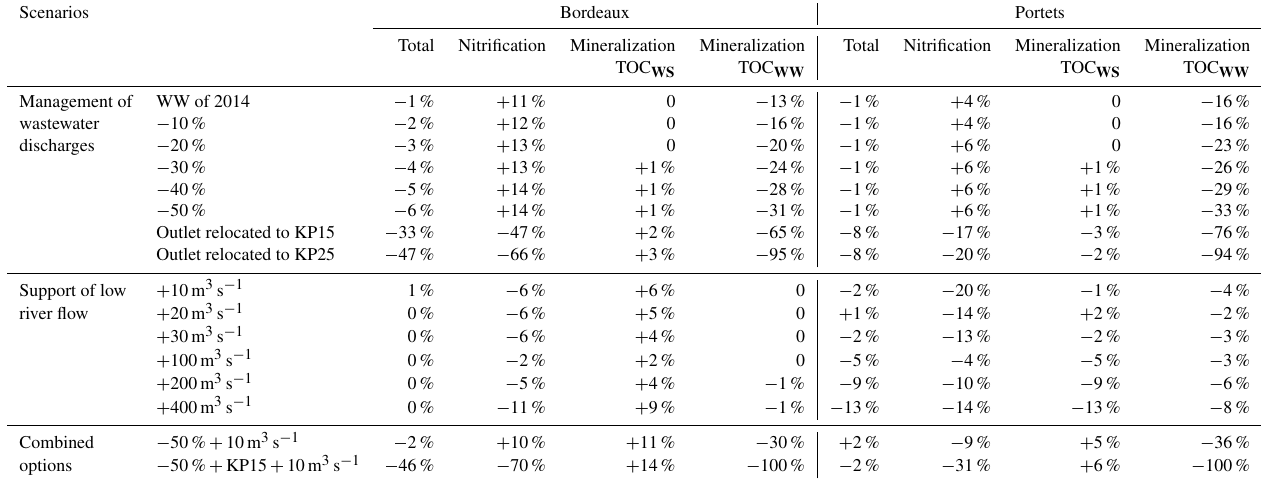
Table 3. Differences (in %) of biogeochemical process rates impacting DO between the scenarios and reference simulations during summer in Bordeaux and Portets (WW: wastewater; WS: watershed). Scenarios Bordeaux Portets Total Nitrification Mineralization Mineralization Total Nitrification Mineralization Mineralization TOC WS TOC WW TOC WS TOC WW Management of WW of